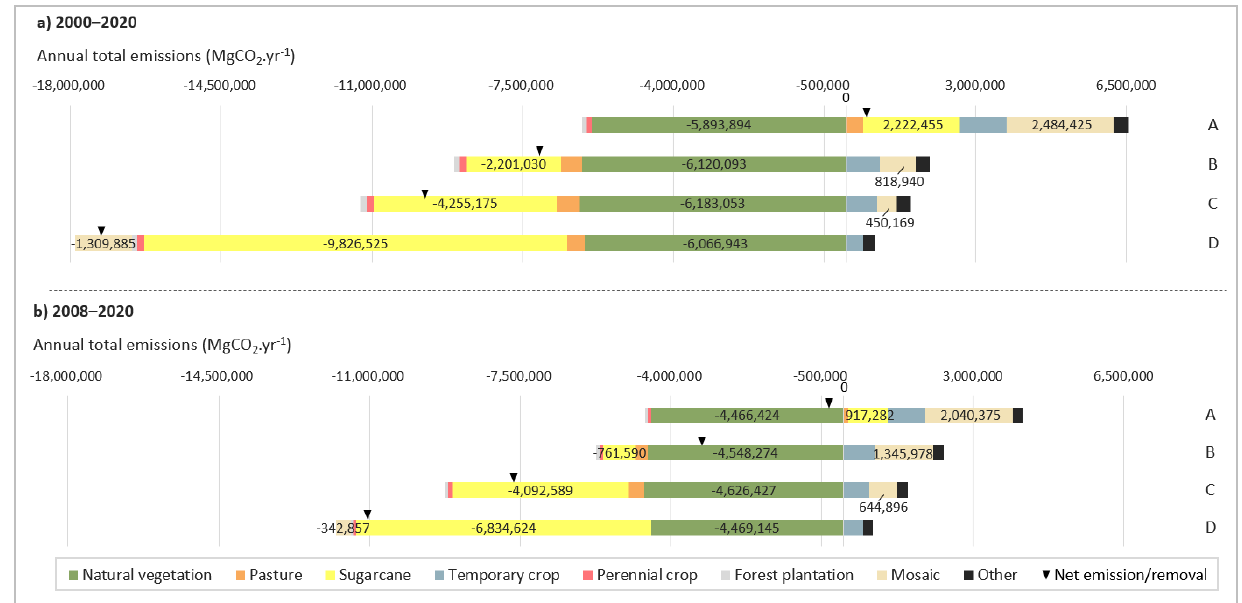
Figure 9. Estimates of absolute annual emissions/removals, in MgCO 2 ∙ yr − 1 , due to all LUCs, in each parametrization, in the sugarcane producing CARs of the center–south and north regions of Brazil, during ( a ) 2000–2020 and ( b ) 2008–2020. The classes shown represent current land use and the emissions/removals associated with the conversion of LUC to the current land use. For example: during 2000–2020, all LUC that led to the current natural vegetation area (in green) resulted in a removal of − 5.89 TgCO 2 ∙ yr − 1 in parametrization A.